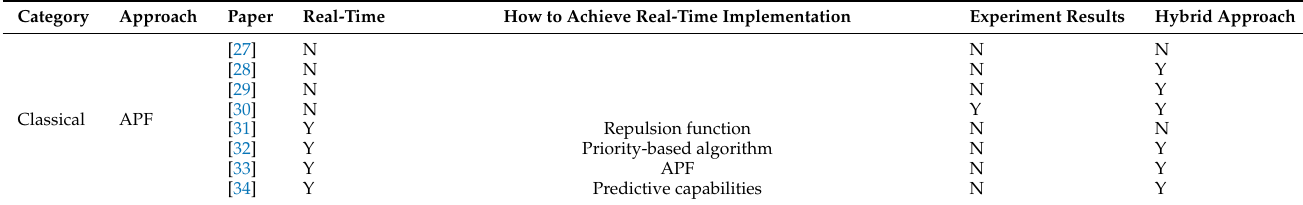
Table 1. Comparison of multi-robot path planning